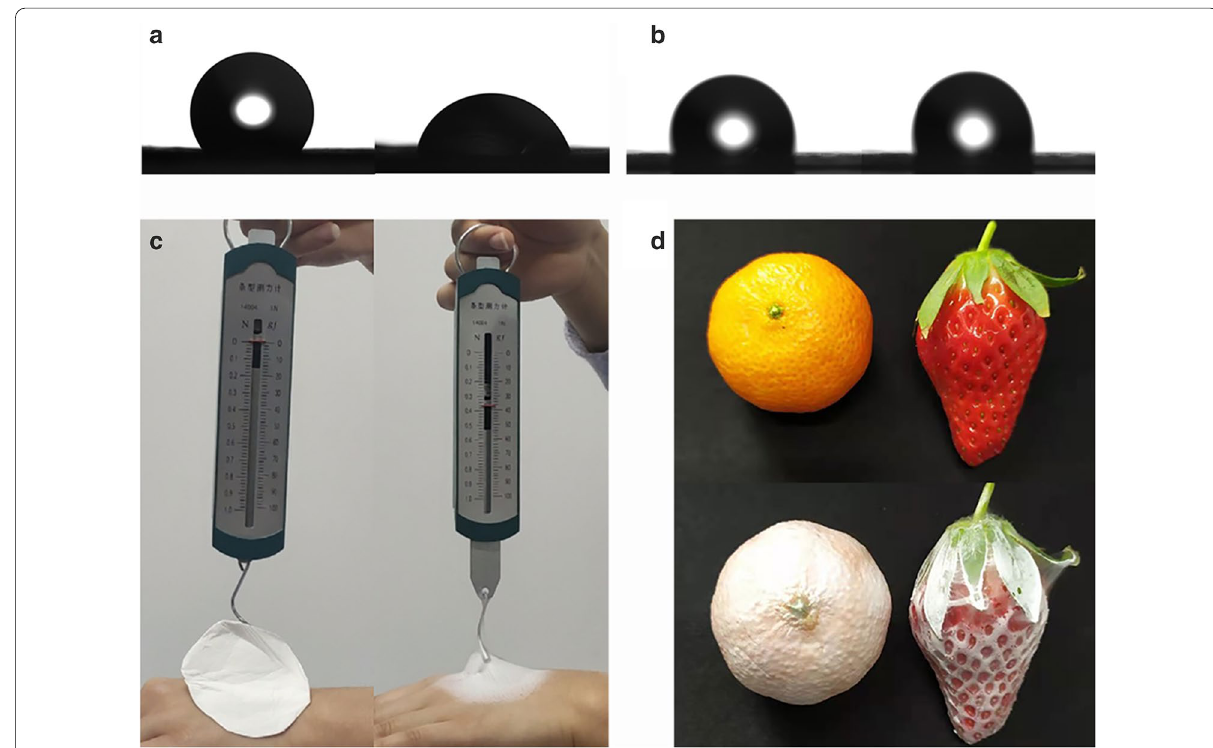
Fig. 4 Water contact angle measurement of composite nanofiber membrane with matrix of a PCL/PVP and b PCL, c traditional electrospun nanofiber membrane and in situ deposition electrospun nanofiber membrane, d in situ deposition electrospun on different object